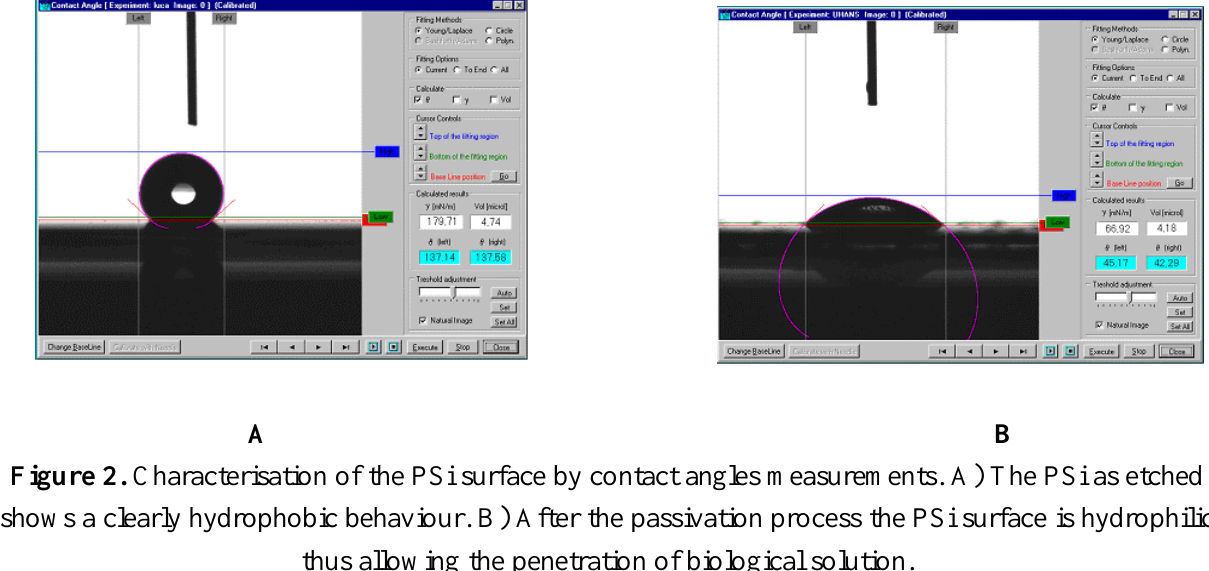
Figure 3: the fluorescent intensities decrease but remain of the same order of magnitude. From